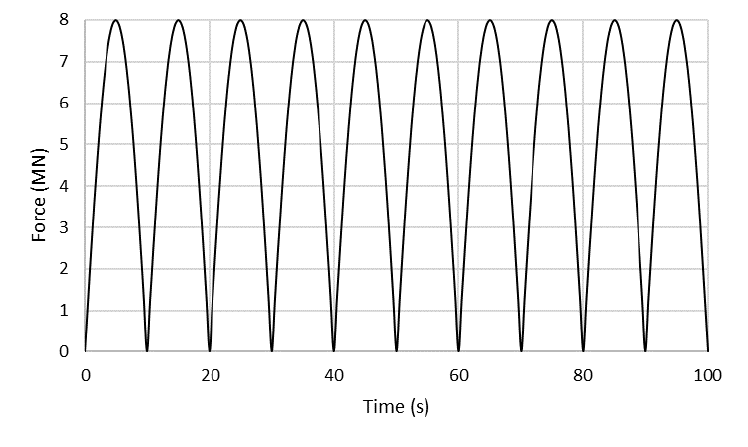
Figure 6. The loading diagram of the first 10 cycles for the 8 MN one-way cyclic